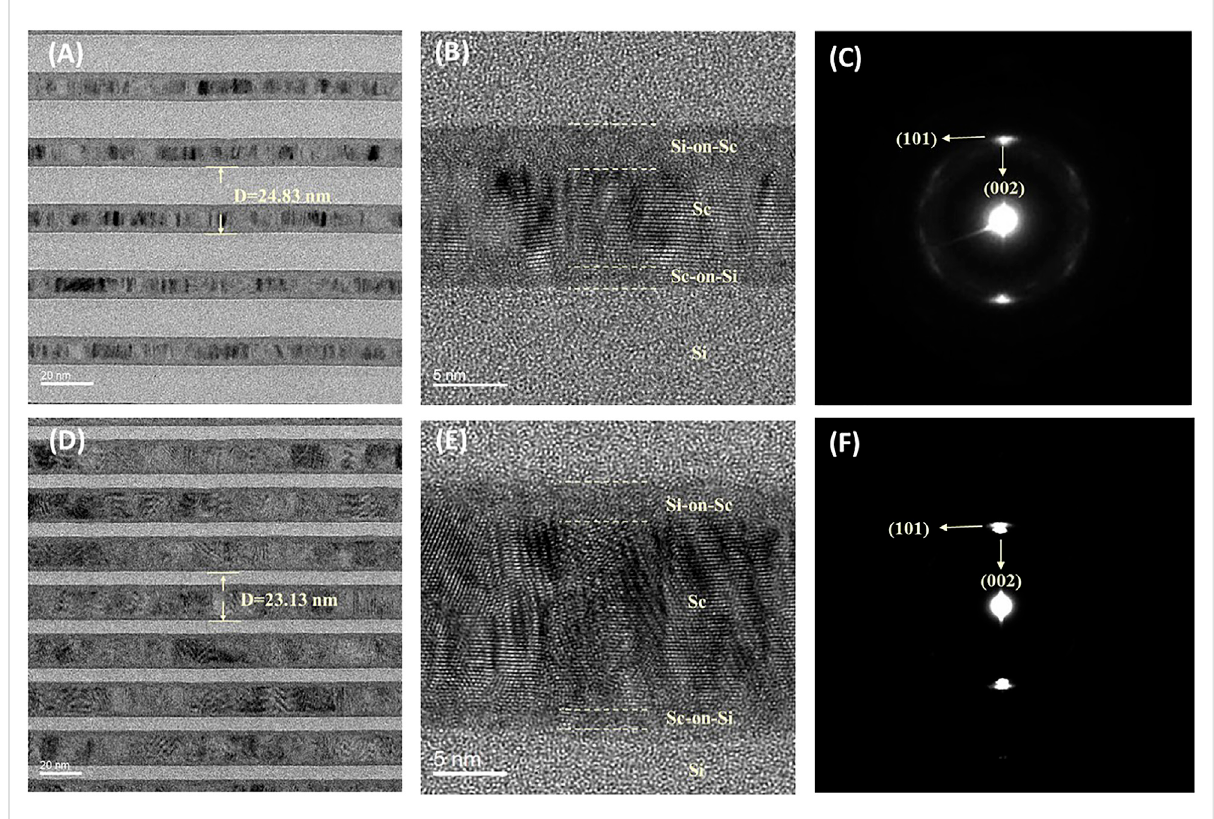
Bright- fi eld TEM and SAED images of Sc/Si multilayers with Γ Sc = 0.35 (A – C) and Γ Sc = 0.65 (D – F)